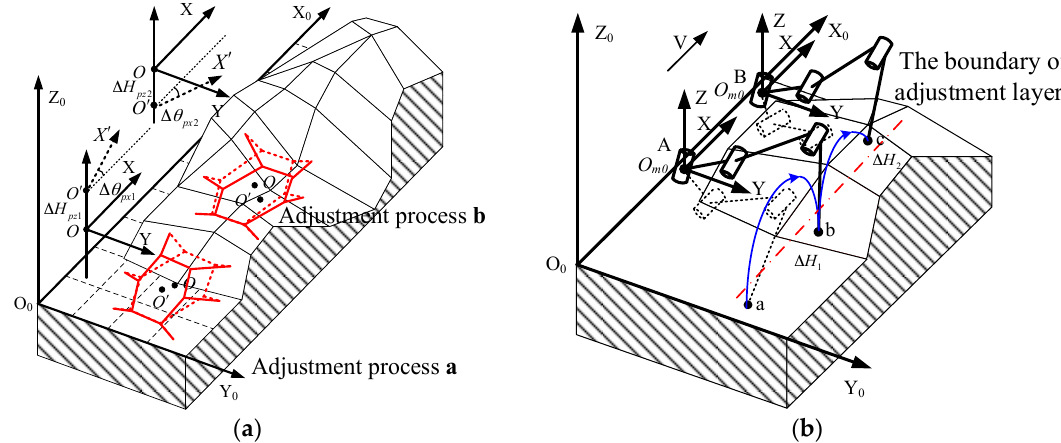
Figure 11. The process of adjusting the pose on severe rugged terrain: ( a ) Analysis of terrain adaption mechanism and ( b ) analysis of pseudo-light rough terrain.